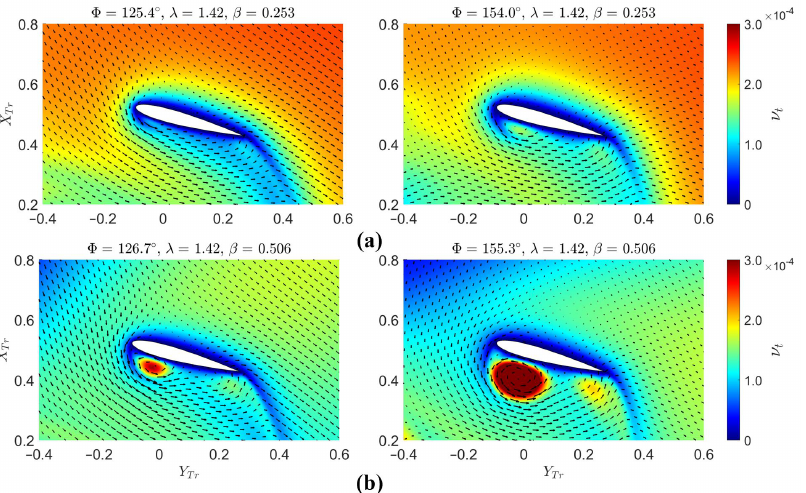
Figure 15. The turbulent viscosity field at β = 25.3% ( a ) and β = 50.6% ( b ) during the generation of the leading edge